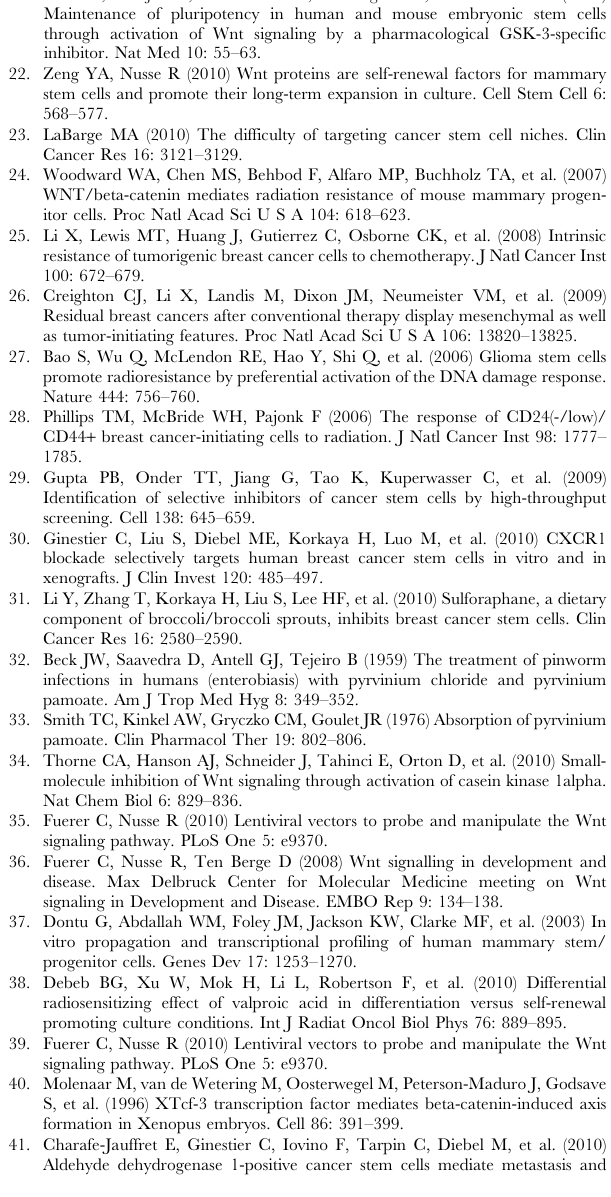
Figure S2 PP might decreased WNT signaling in vivo . Nude